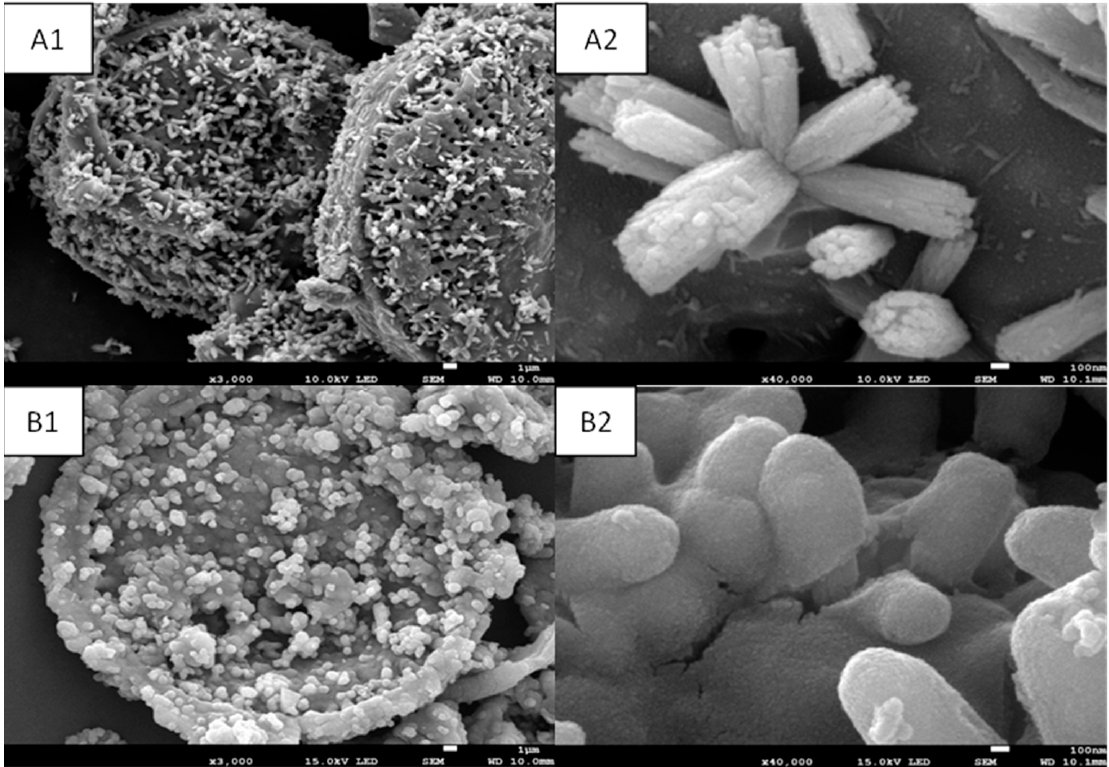
Figure 2. SEM pictures with different magnifications of ( A1 , A2 ) ZnO(10%)/diatomite and ( B1 , B2 ) TiO 2 (30%)/ZnO(10%)/diatomite.